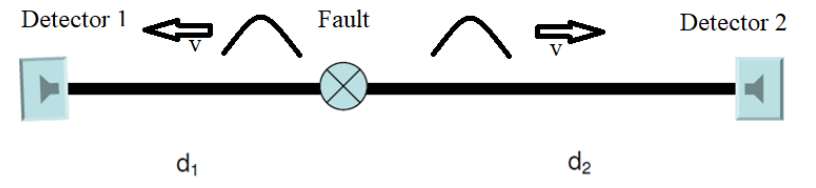
Figure 1. Transmission line with a short and